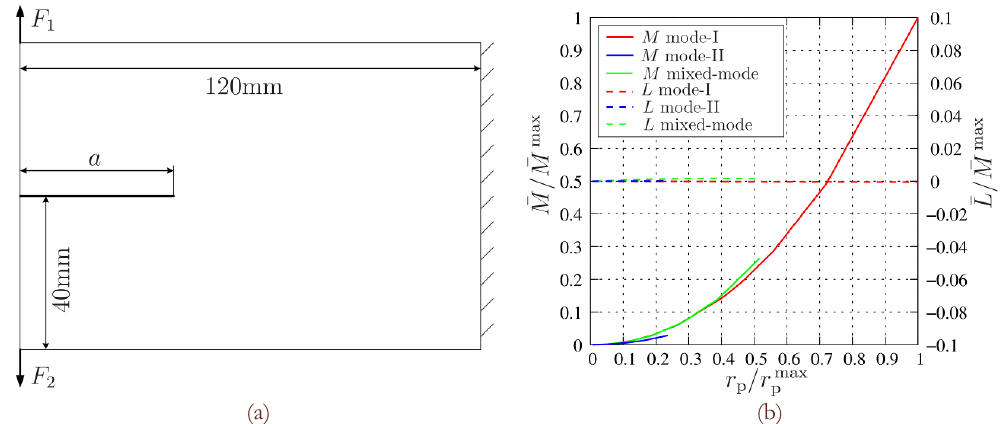
Figure 4: (a) DCB specimen with applied loads F 1 and F 2 and crack length a = 40mm, (b) normalized global M - and L -integrals with a linear elastic-perfectly plastic material model vs. the normalized plastic zone size max